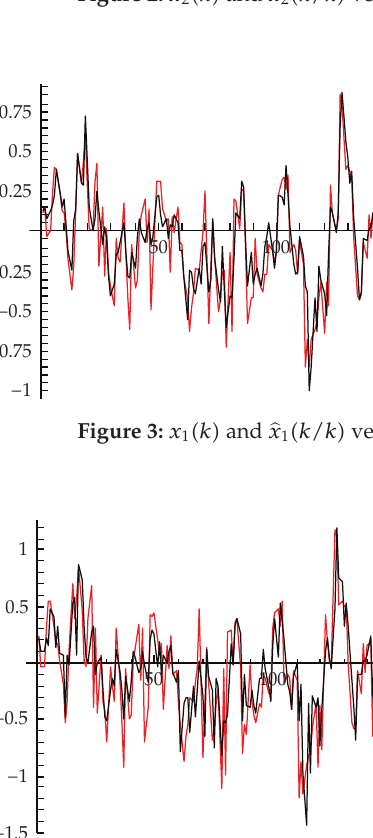
Figure 2: x 2 (cid:5) k (cid:6) and (cid:11) x 2 (cid:5) k/k (cid:6) versus k .